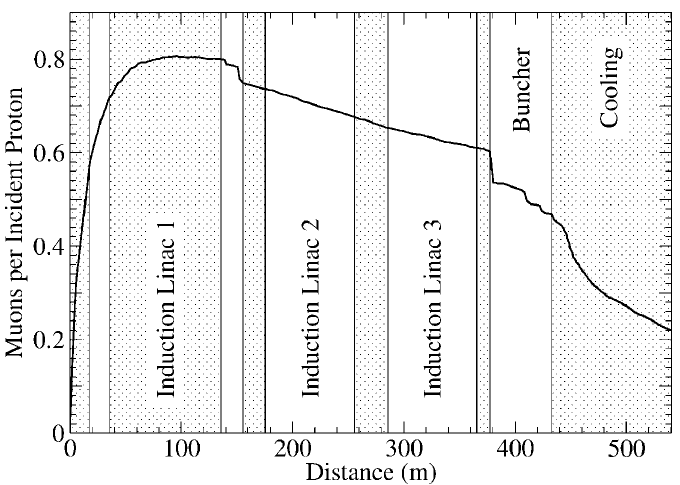
FIG. 26. Muons per incident proton in the study-II neutrino factory front end.